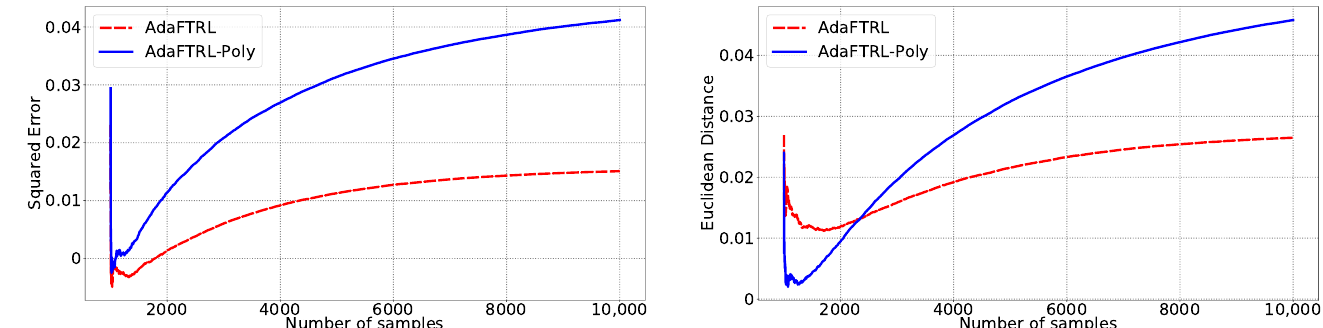
Figure A1. Relative performance for setting 1.